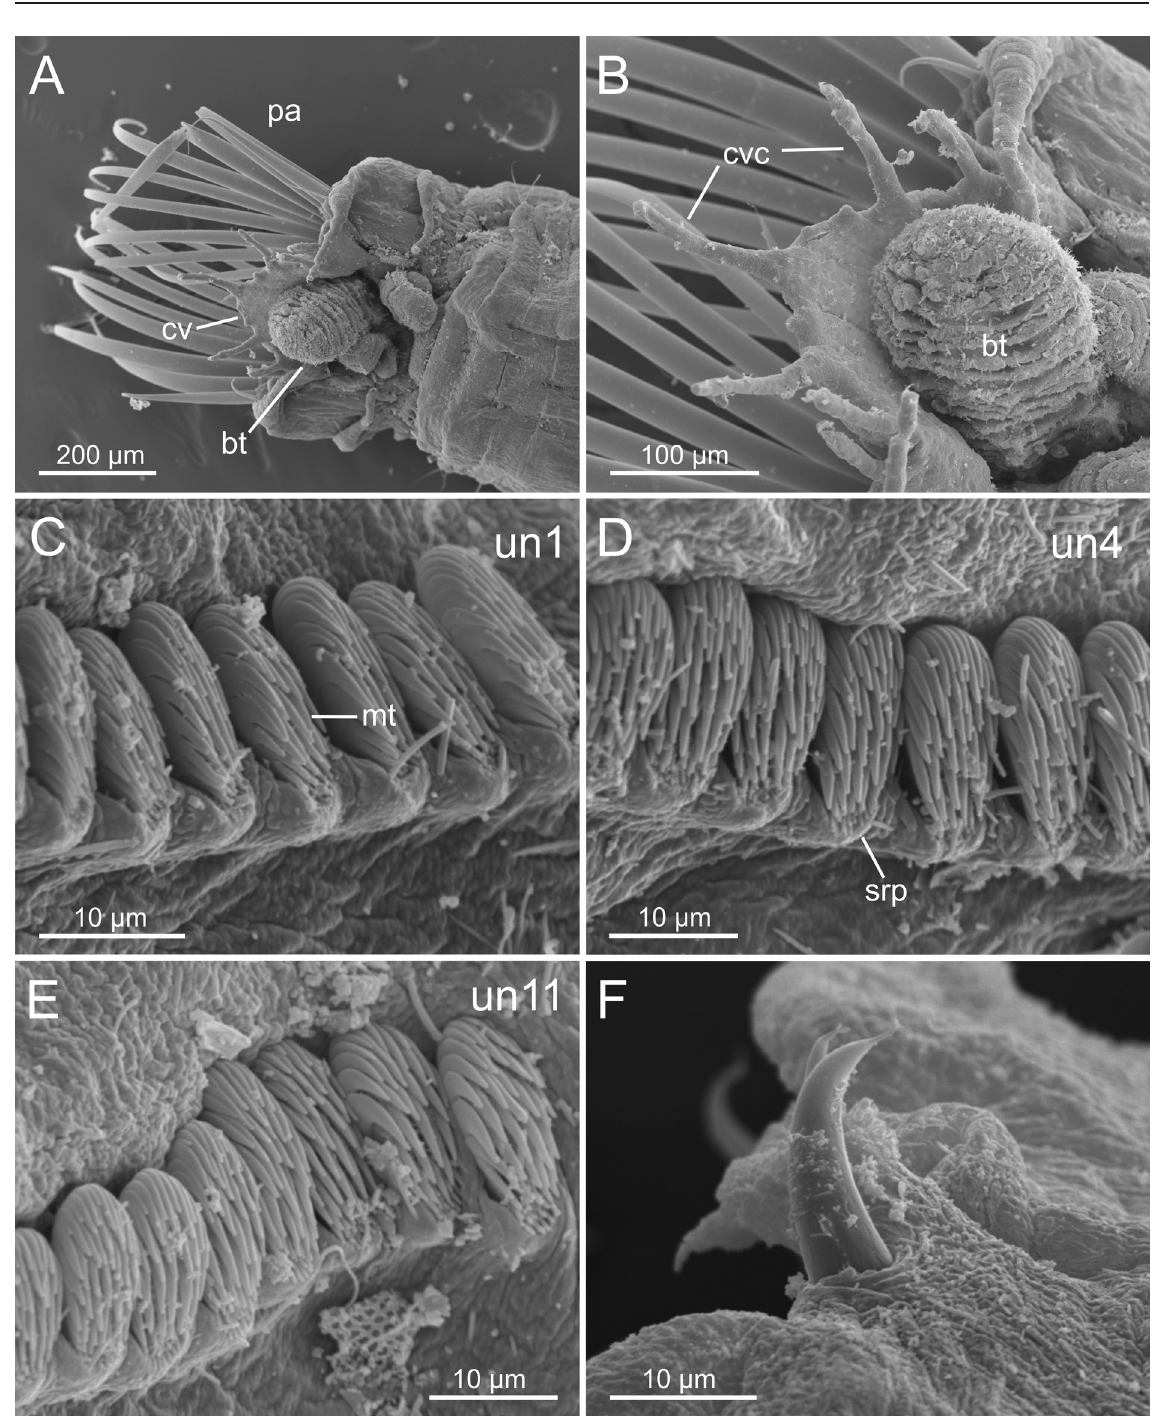
Fig. 17. Lagis koreni Malmgren, 1866. SEM micrographs of a small specimen (BIOICE sample 3078, IINH-40486). A . Anterior end, ventral view. B . Cephalic veil, detail. C–E . Uncinigers 1, 4 and 11, uncini. F .